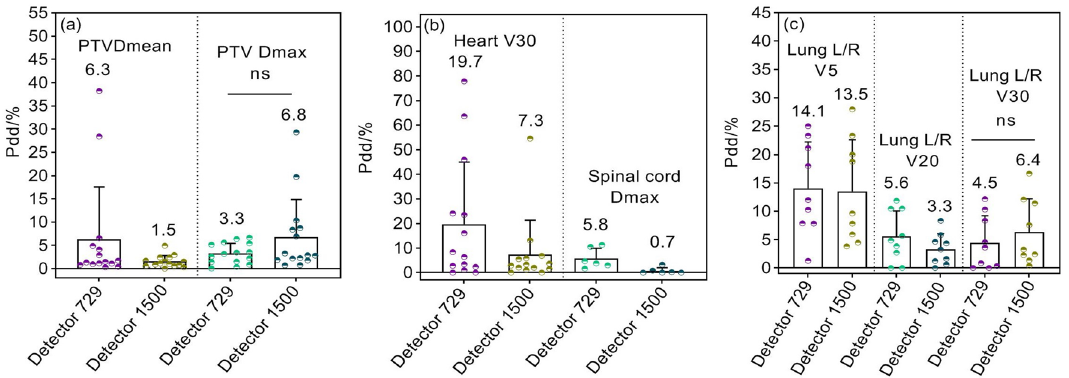
Figure 9. Pdd/% for mediastinum and lung plans. ( a ) Percent dose deviations of mean and maximum doses in PTVs; ( b ) Percent volume deviations of heart exposed to a dose of 30 Gy, and percent dose deviation of maximum dose in spinal cord; ( c ) Percent volume deviations of bilateral lungs exposed to a dose of 5 Gy, 20 Gy, and 30 Gy,